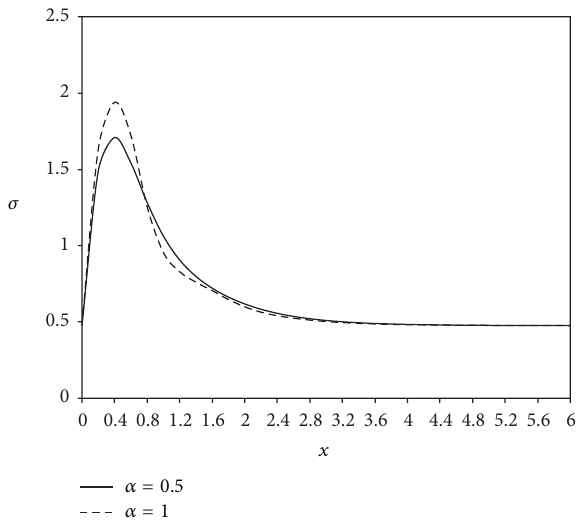
Figure 3: Stress distribution 𝜎 for different values of 𝛼 at 𝑡 = 0.1